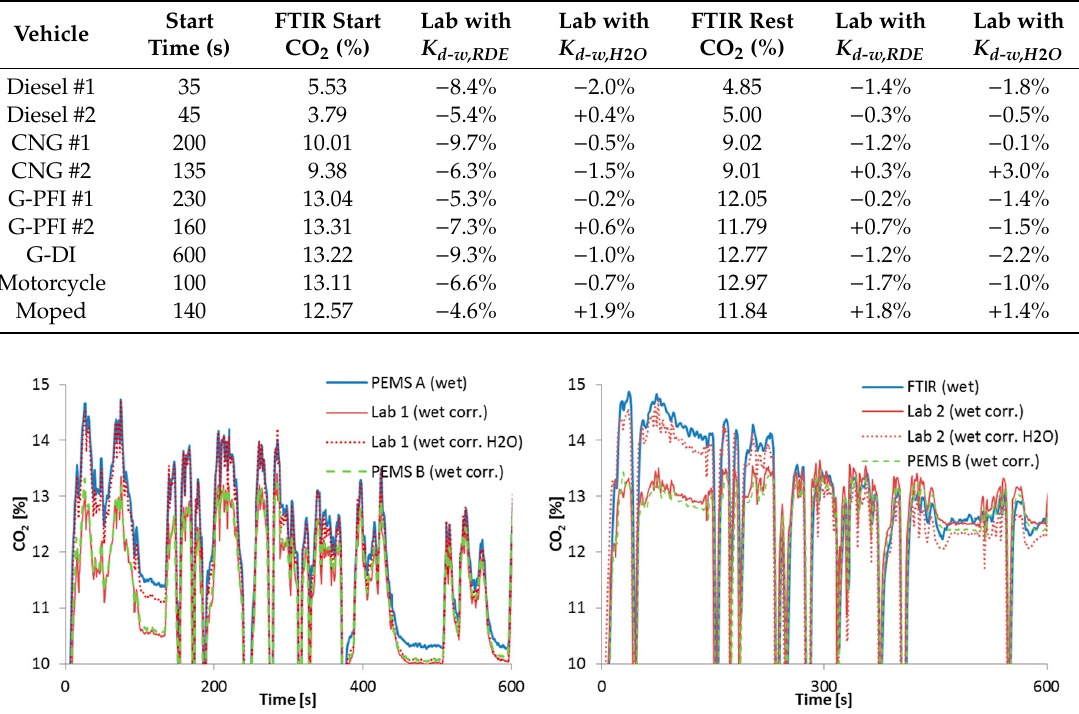
Figure 4. Comparison of different analyzers during a cold start WLTC of the Gasoline Port Fuel Injection (G-PFI) #1 vehicle. Left panel: Laboratory 1, portable emissions measurement system (PEMS) A, and PEMS B. Right panel: Laboratory 2, PEMS B, and FTIR.